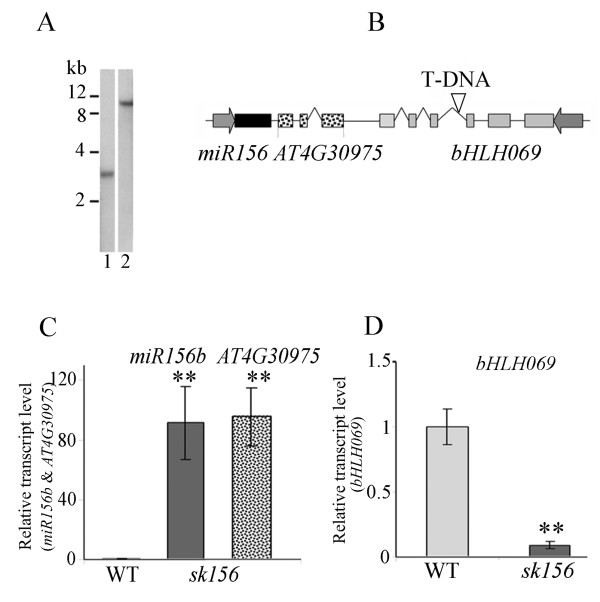
T-DNA insertion site and affected genes in sk156 mutant. (A) Southern blot analysis of sk156 showing a single T-DNA insertion. Lane 1, digested with BamHI. Lane 2, digested with HindIII. (B) Schematic of T-DNA inserted in the third intron of bHLH069 shown by ‘∇’ (empty triangle). Boxes, exons; Lines, introns and intergenic regions. Thick grey arrows show promoter regions and their transcription direction. (C) Transcript levels for miR156b and unknown RNA gene (AT4G30975) in sk156 relative to WT (set at 1) using qPCR. (D) Transcript levels for bHLH069 in sk156 relative to WT (set at 1) using qPCR. A Duncan's multiple range test in (C) and (D) showed significant differences of the means (± standard deviation) between sk156 and WT Col-4 at p < 0.01 (**) and p < 0.05 (*).